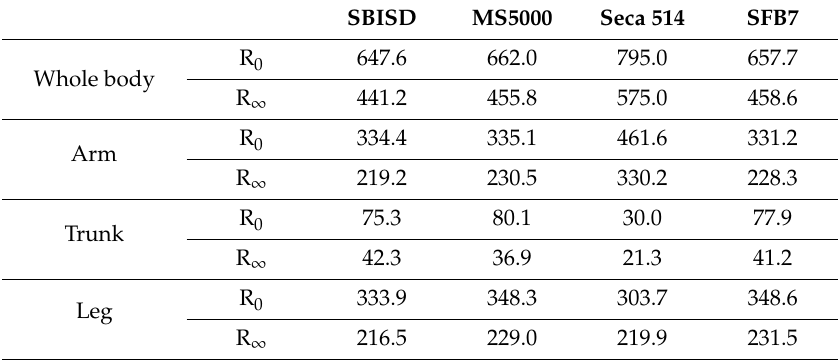
Table 1. Device comparison for subject 1.